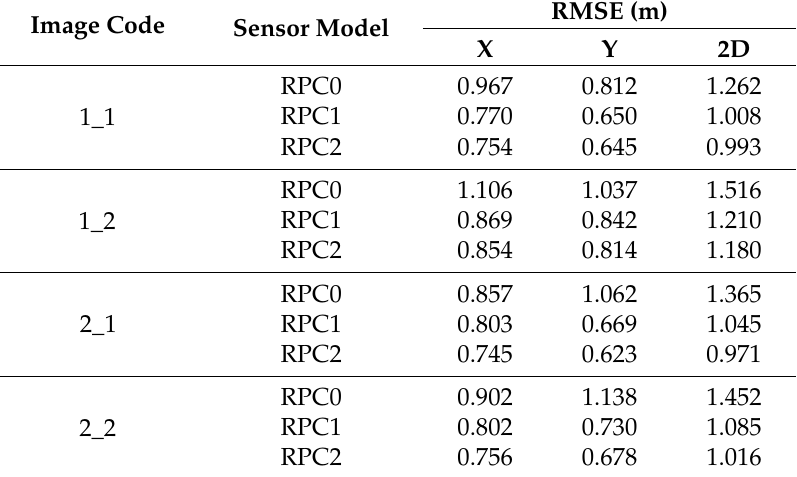
Table 3. Sensor orientation accuracy (RMSE) using rational polynomial coe ffi cient RPC0, RPC1 and RPC2 sensor models supported by 102 GCPs.